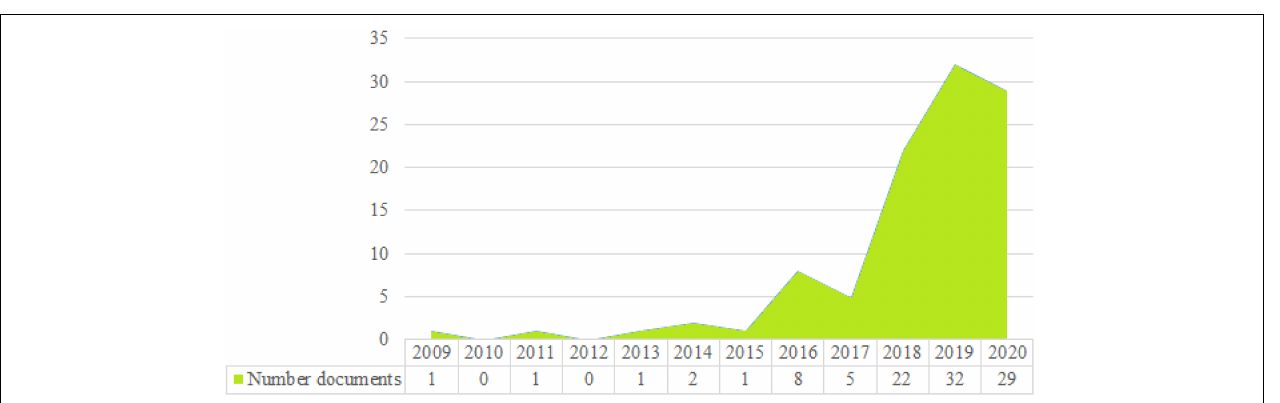
FIGURE 2 | Number of publication per year. Source: Own elaboration from SciMAT